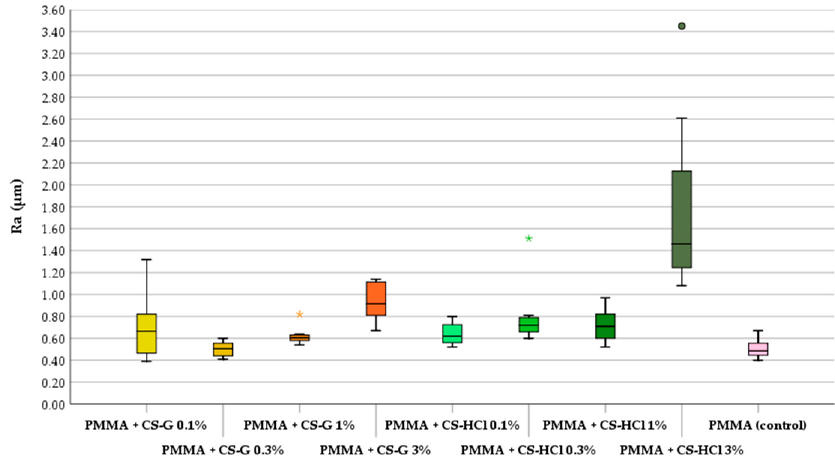
Figure 2. Roughness (Ra) in each group (box plot: median of mean roughness, 25% and 75% quartiles, * and • indicate extremes); polymethylmethacrylate (PMMA), chitosan glutamate (CS-G), chitosan-hydrochloride (CS-HCl).